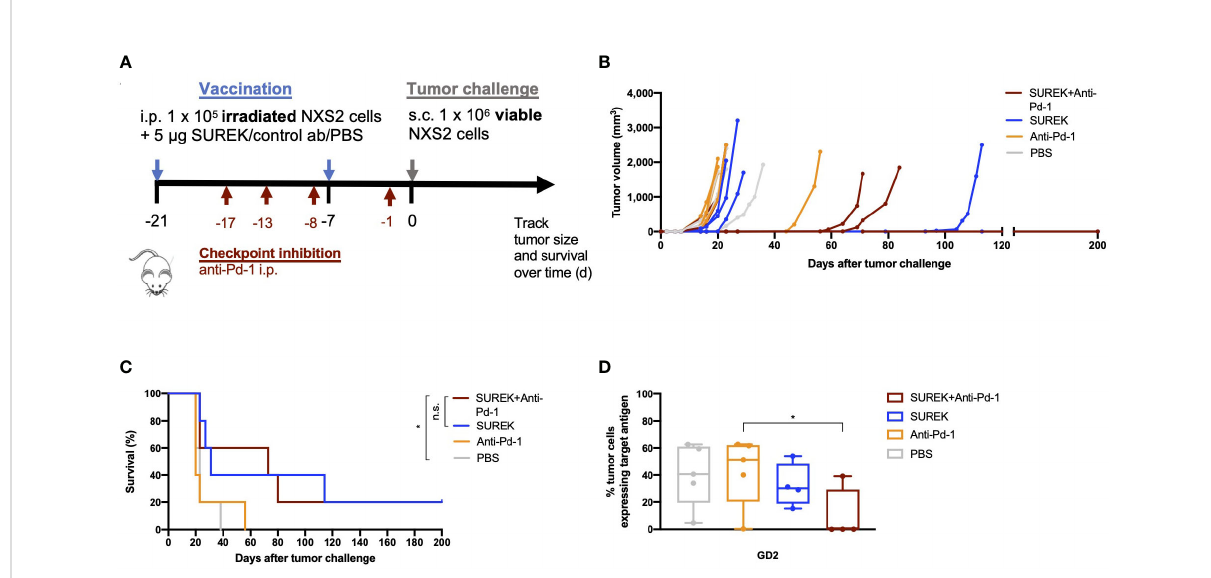
FIGURE 4 Combination therapy of SUREK and anti-Pd-1 does not signi fi cantly enhance overall survival of mice but shows a trend to immunogenicity in comparison to treatment with SUREK alone. (A) Schematic representation of treatment and analysis. A/J mice were vaccinated with intraperitoneal injection (i.p.) of 1 x 10 5 irradiated NXS2 cells and a simultaneous i.p. injection of 5 µg of SUREK (n=5) or only PBS (n=5) on day -21 and -7. For combination therapy animals received anti-Pd-1 blocking antibody (n=5) on days -17, -13, -8, -1, control mice received PBS (n=5) or anti-Pd-1 blocking antibody (n=5) alone. On day 0 all mice were challenged with a subcutaneous injection of 1 x 10 6 viable NXS2 cells which were injected subcutaneously into their right fl ank. (B) Tumor size was checked every other day via calipermetry. (C) Survival of mice is shown in a Kaplan-Meier-Curve. Statistical analysis was done using log-rank test to compare different groups: *p<0.05; n.s.: not signi fi cant. (D) Tumors that grew out after combination therapy were isolated and analyzed for GD2 surface expression using fl ow cytometry. Statistical analysis was done using Mann-Whitney test to compare different groups: